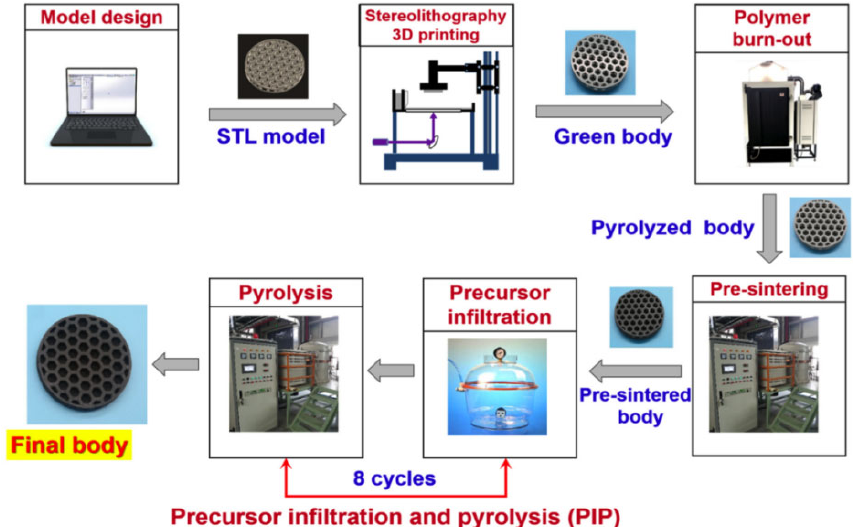
Fig. 31 Fabrication flow chart of SiC ceramic by DLP and PIP. Reproduced with permission from Ref. [87], © Elsevier Ltd and Techna Group S.r.l.